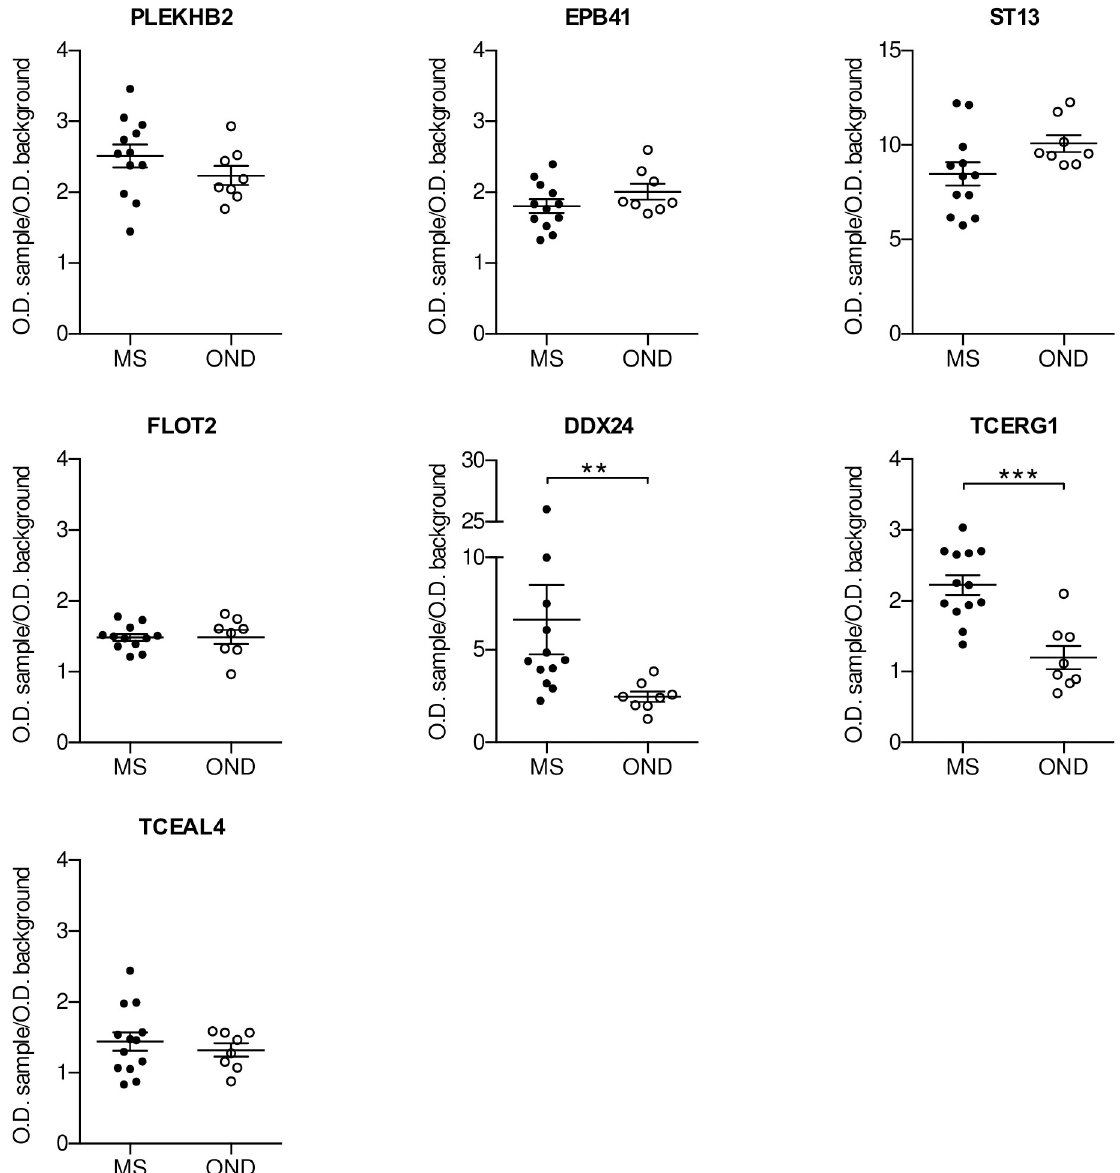
Fig 2. ELISA validation of putative biomarkers. Clones isolated by the selection of the HB library were validate by Phage-ELISA using CSFs of MS (n = 12) and OND (n = 8) patients (cohort 1, Table 1). Individual biological replicates are shown. Error bars indicate mean +/- SEM. Mann-Whitney test has been used to assess statistical significance; �� p < 0.01, ��� p < 0.001.